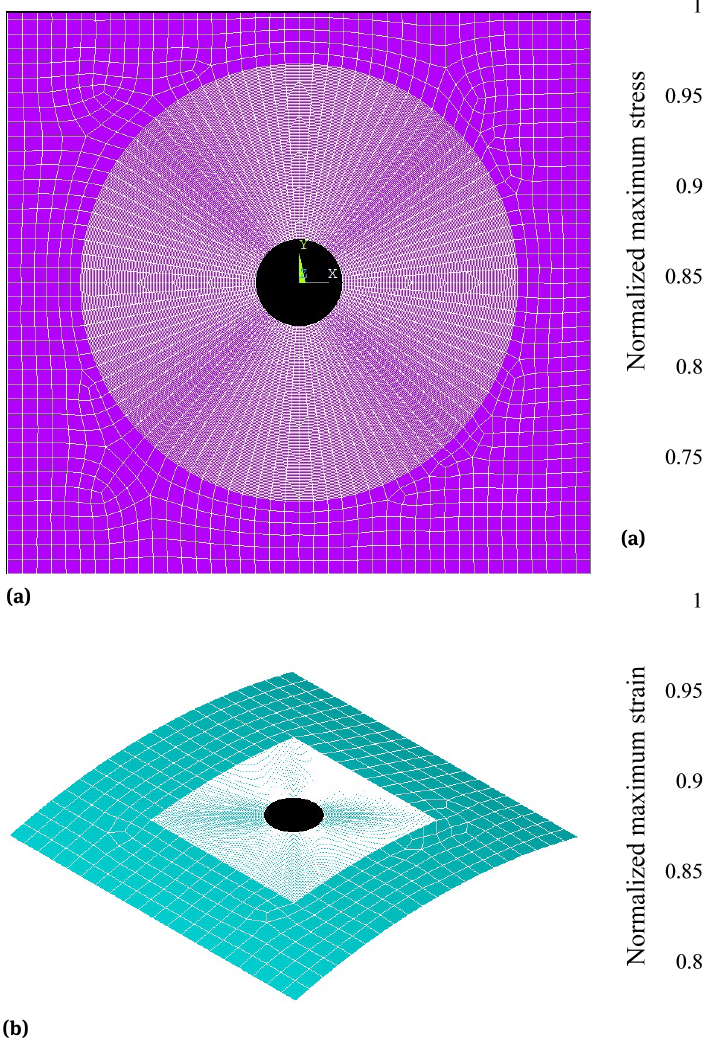
Figure 4: Free and mapped meshing (around hole) in (a) flat and (b) singly curved composite plates